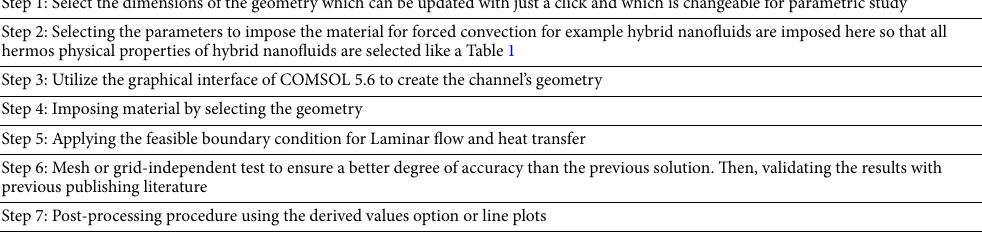
Table 2. The working Wagon Wheel of COMSOL